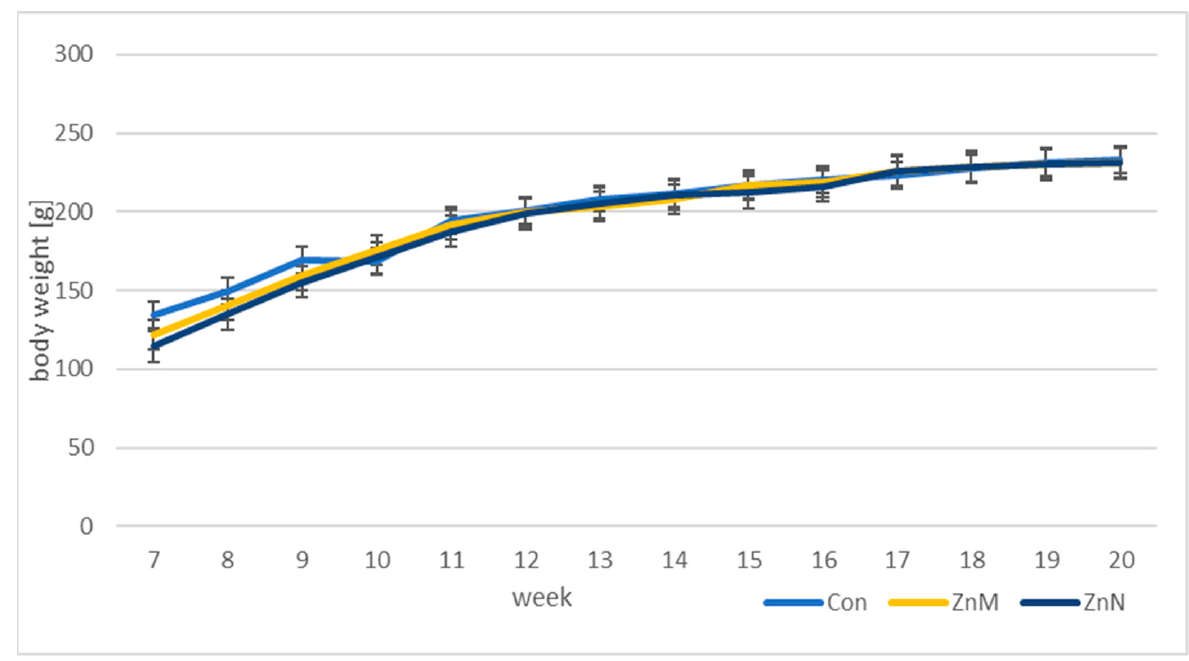
Figure 1. Changes in average body weight of the rats in experimental groups. The applied diet modification did not affect the weight of the liver, kidneys, spleen and heart of the examined